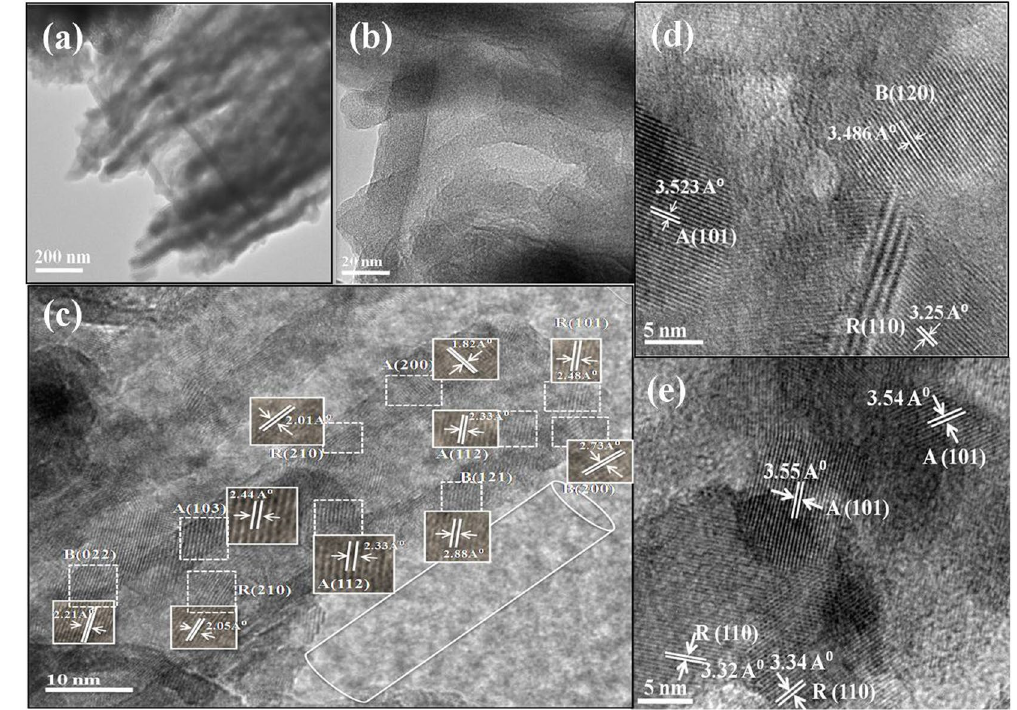
Figure 4. Bright field TEM image: ( a ) T-ARB and ( b ) NT-1.5; HRTEM images: ( c ) T-ARB ( d ) NT-1.5 and ( e ) NT-4.5.